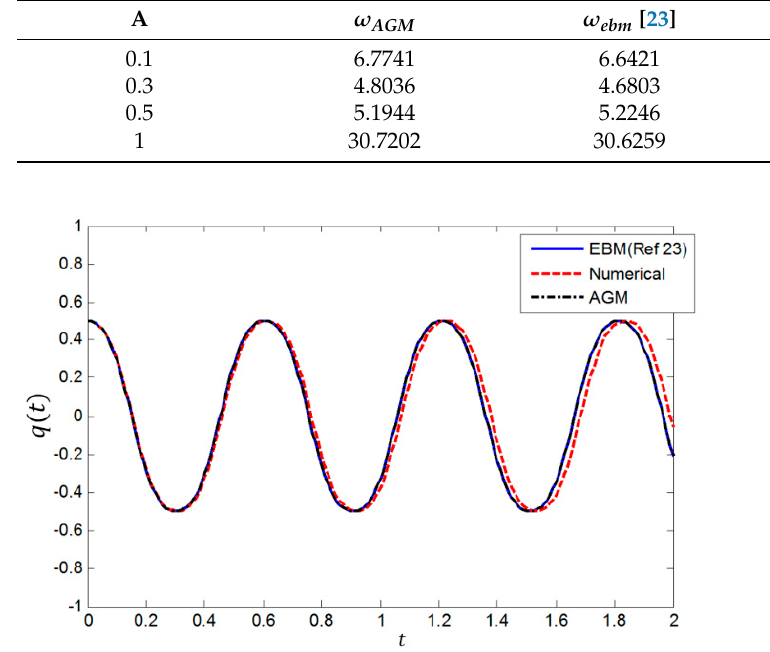
Table 5. Comparison between AGM, EBM, and exact numerical solution (S-S beam).